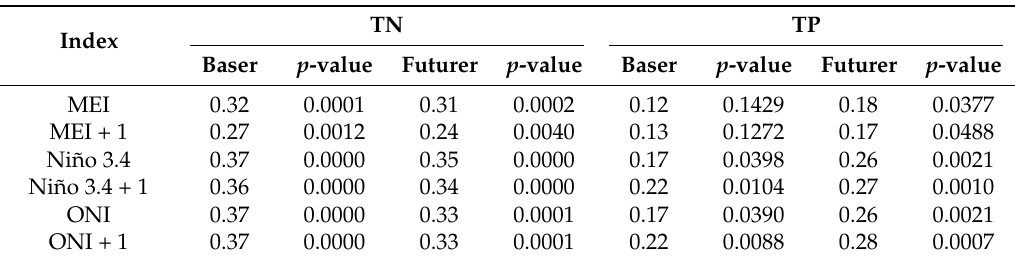
Table 6. Correlation between ENSO indices and Converse Reservoir simulated monthly TN and